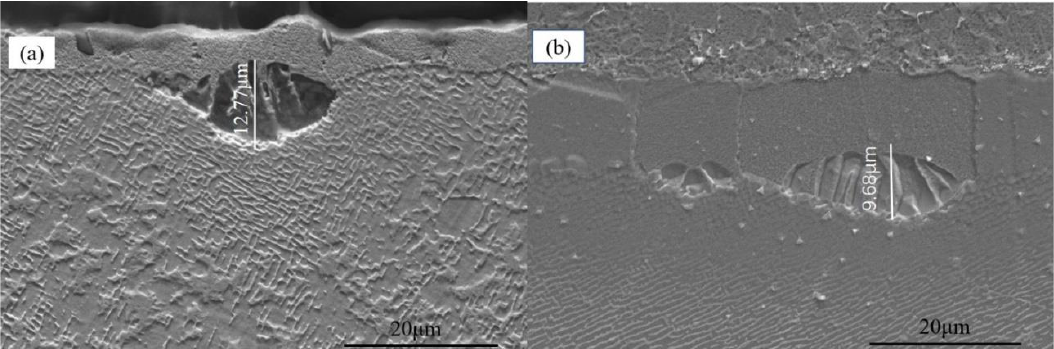
Figure 4. Specimen recrystallization morphology at 0.3 MPa sandblasting pressure in ( a ) uncoated and ( b ) coated alloys .